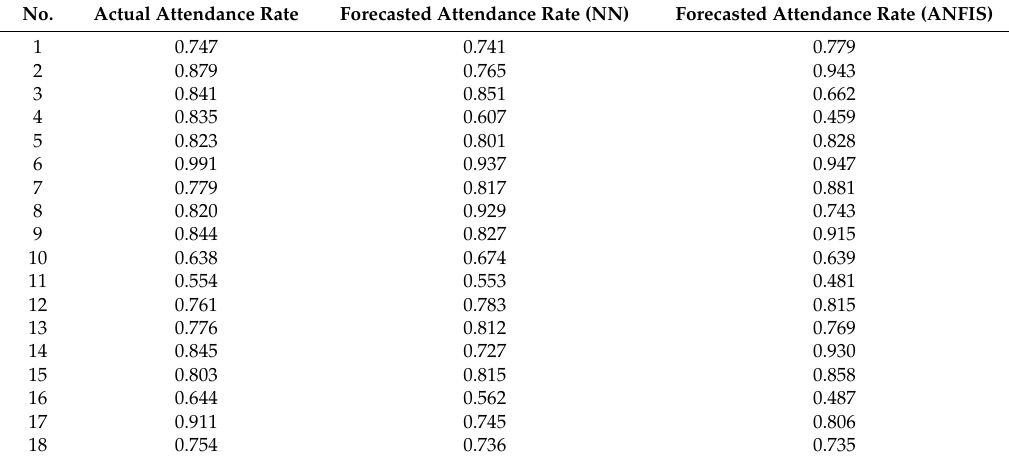
Table 4. Comparisons of actual and forecasted attendance